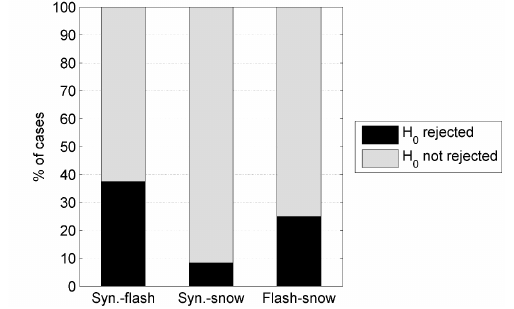
Table 2. Number of identified independent flood events, stratified by regions and flood types. ALL SITES = all sites included (72 sites with no regional delineation), SUBREGION #1 = Innviertel + Hausruckviertel, SUB- REGION #2 = Traunviertel + Flysh and SUBREGION #3 = Mühlviertel + Waldviertel. Number of All Synoptic Flash Snowmelt catchments floods floods floods floods ALL SITES 72 25697 19093 4871 SUBREGION #1 Figure 2. Results of the comparison of the empirical copulas lo- cally: per cent ratio of the catchments where the equivalence of the pairs of empirical copulas was rejected or could not be rejected at the given level of significance (here α = 10%). The black color in- dicates the per cent ratio of the catchments where the null hypoth- esis about the equality of the empirical copulas for the given two flood processes was